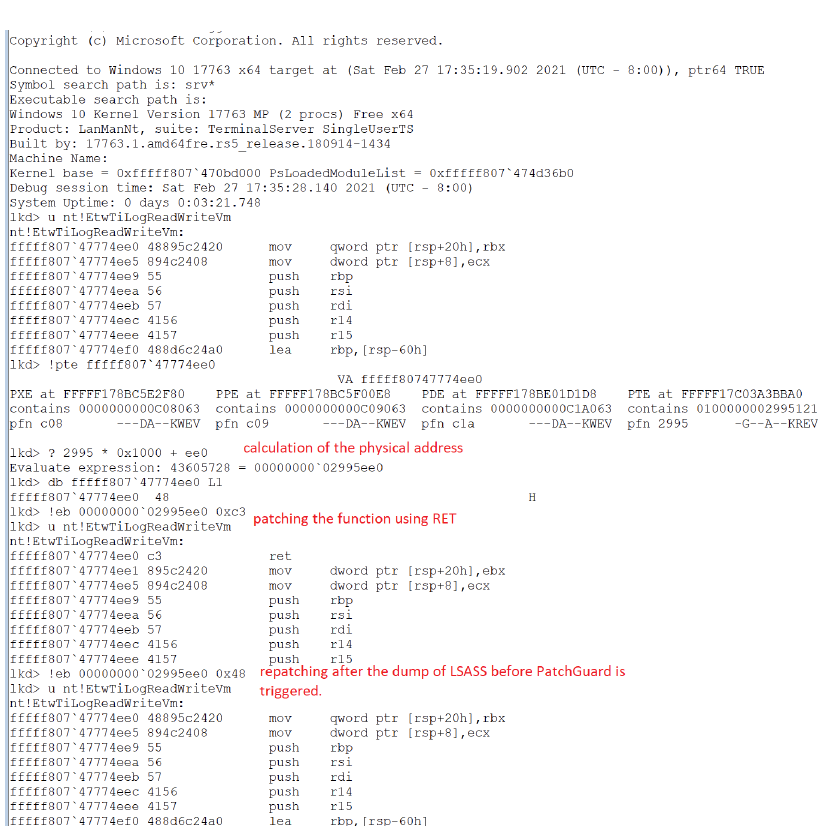
Figure 33. Patching the ETWTi function